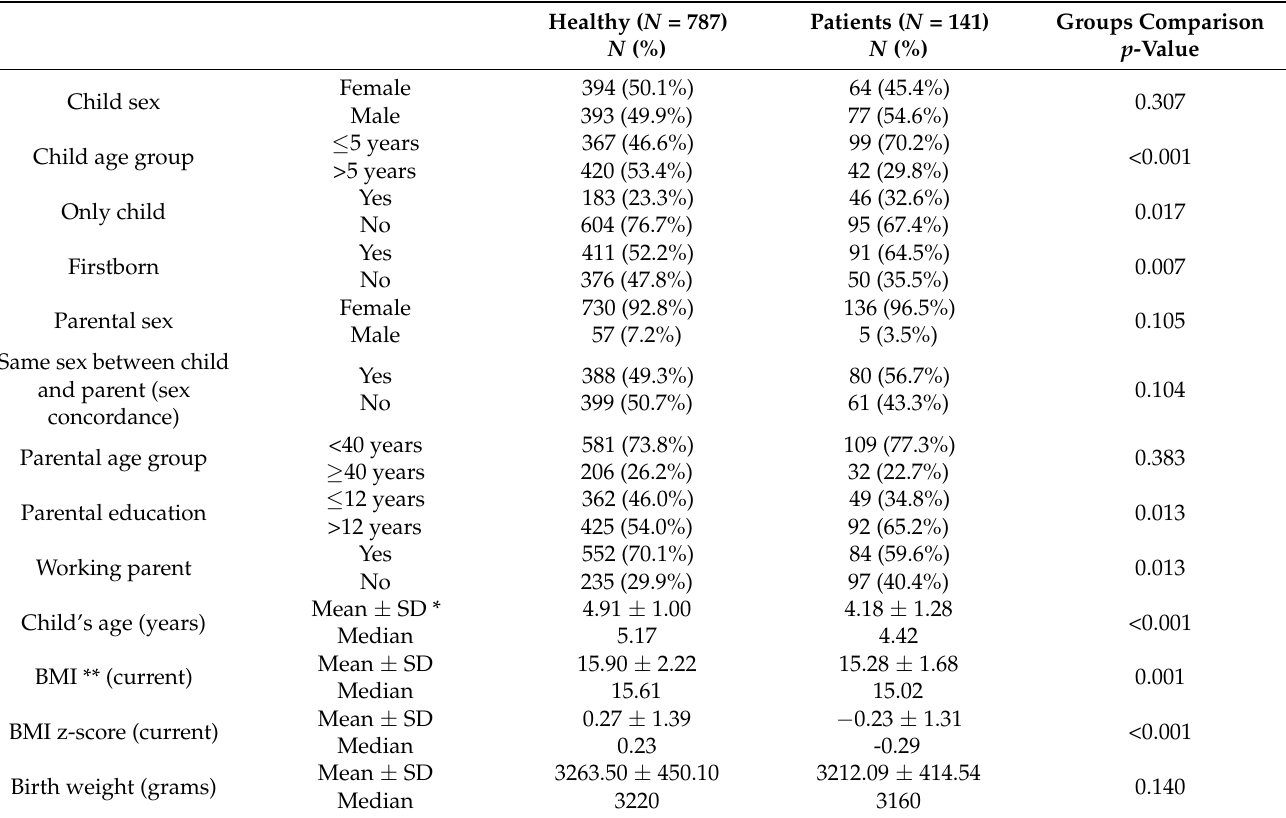
Table 1. Children’s and parents’ demographic characteristics and children’s anthropometric characteristics in the two groups (healthy children vs. children with gastrointestinal